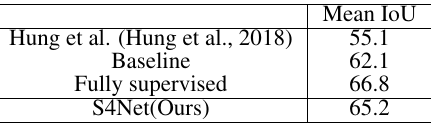
Table 2. The results on validation